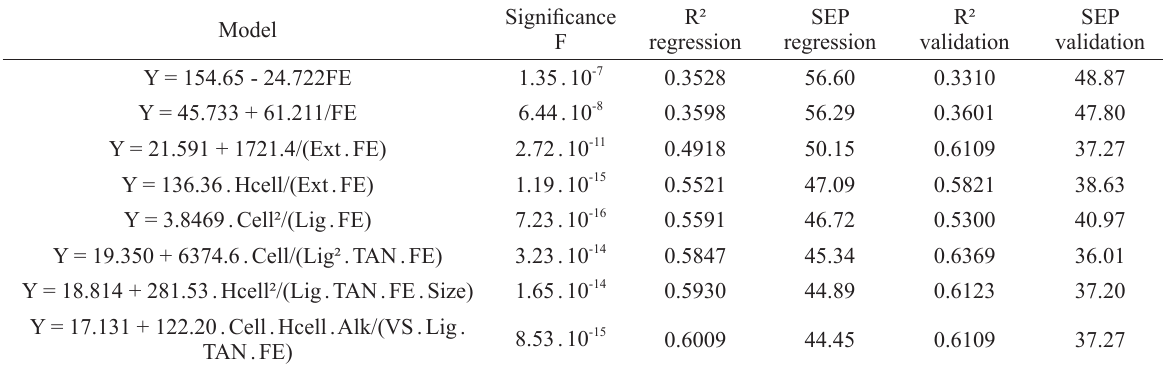
Figure 1 - Methane yield as a function of ( a ) volatile solids, ( b ) lignin content, ( c ) feedstock-to-effluent ratio and ( d ) carbon-to- nitrogen ratio. Summary of simple linear regression